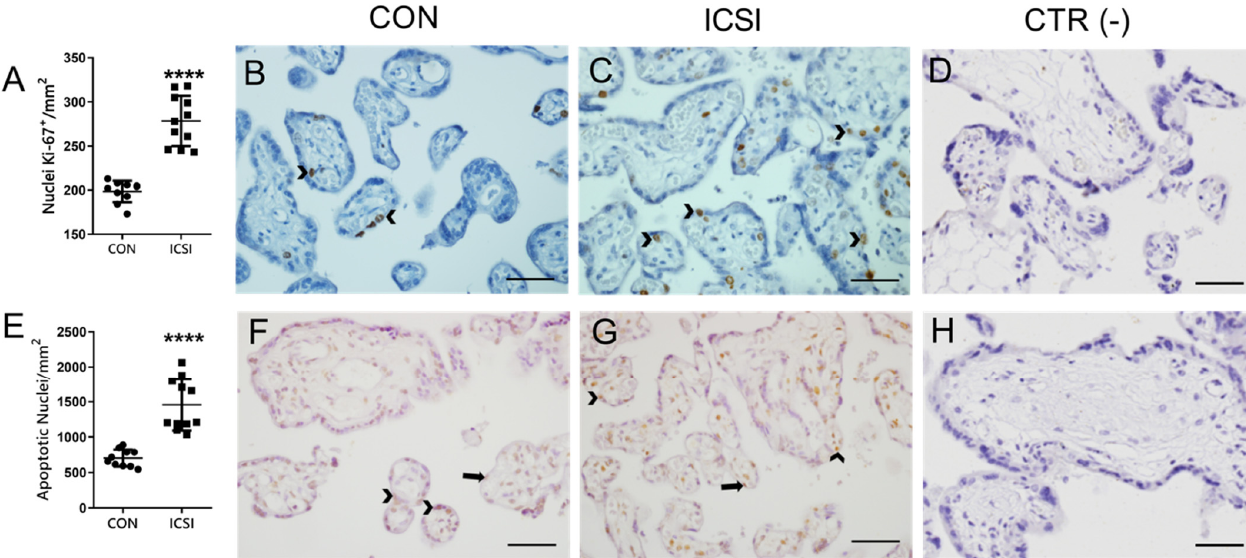
Figure 4. Placental proliferation and apoptosis are increased in the human ICSI placenta. Semiquantitative staining scores ( A , E ) and corresponding representative immunostaining photomicrographies of Ki67 ( B , C ) and TUNEL ( F , G ) obtained from term human naturally (CON; n = 10) conceived and ICSI ( n = 11) placentae. ( D , H ) negative controls. ( A , E ) data are presented as mean ± SD. Statistical differences were analyzed using Unpaired t -test. **** p < 0.0001. Arrows indicate syncytium nuclear staining; arrowheads indicate cytotrophoblastic nuclear staining. Scale bar = 50 μ m.